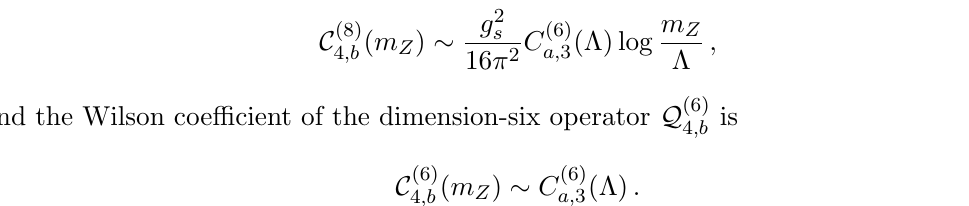
Figure 6 . Left: \electroweak (cid:12)sh" diagram that induces the mixing of Q (6) Higgs operators, Q (6) . Right: tree-level diagram that generates the dimension-eight operators from 16 the Higgs operators through matching at the weak